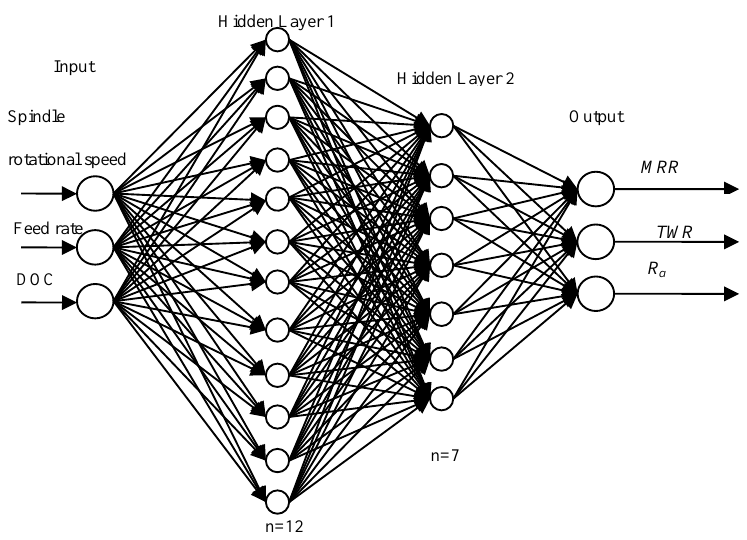
Figure 9. ANN architecture with two hidden layers. Mathematics 2019 , 7 , x FOR PEER REVIEW